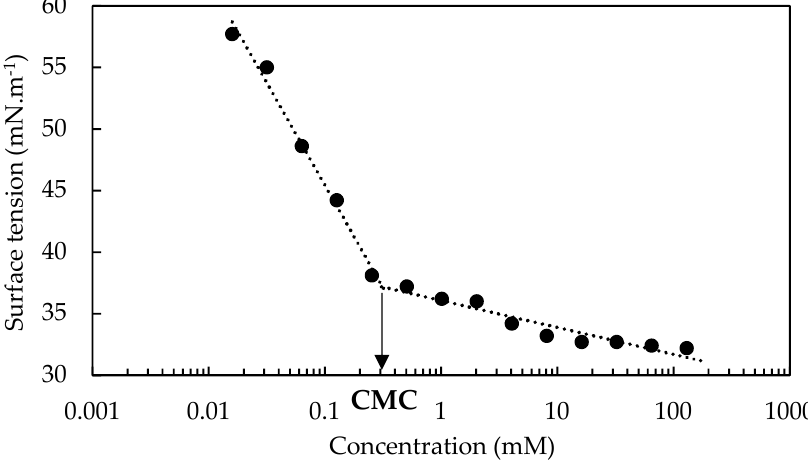
Figure 6. Surface tension as a function of the logarithm of surfactant concentrations for the CMC determination.